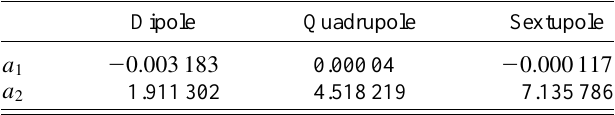
TABLE II. Enge functions with only two parameters, com- puted by slightly modifying the second default Enge coefficient (cid:1) a (cid:2) such that the corresponding Enge functions have the same 2 integral. Dipole Quadrupole